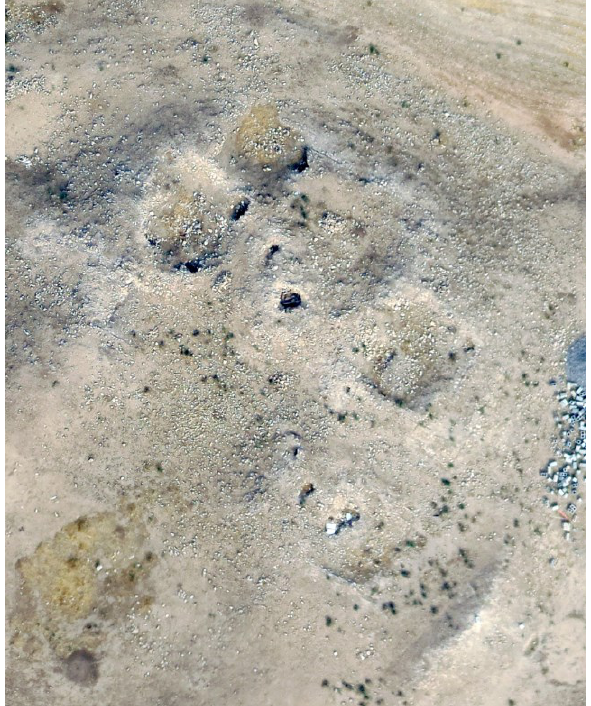
Figure 9. RPAS orthophoto of the defunct